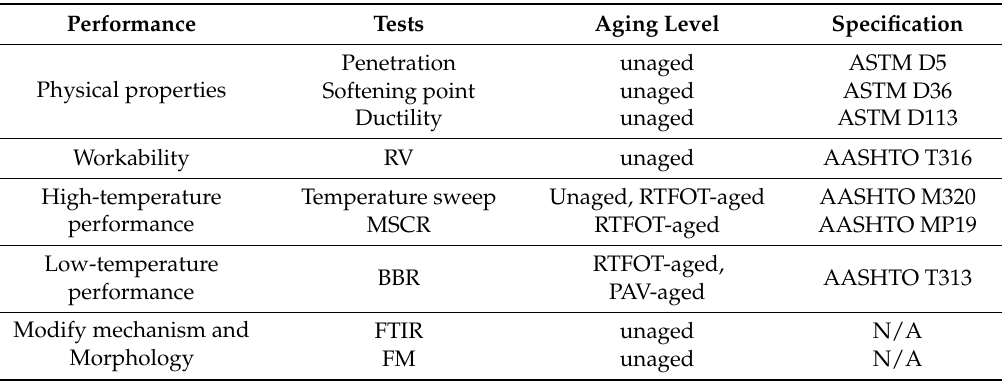
Table 2. Experimental plan of the WEB-modified binder.